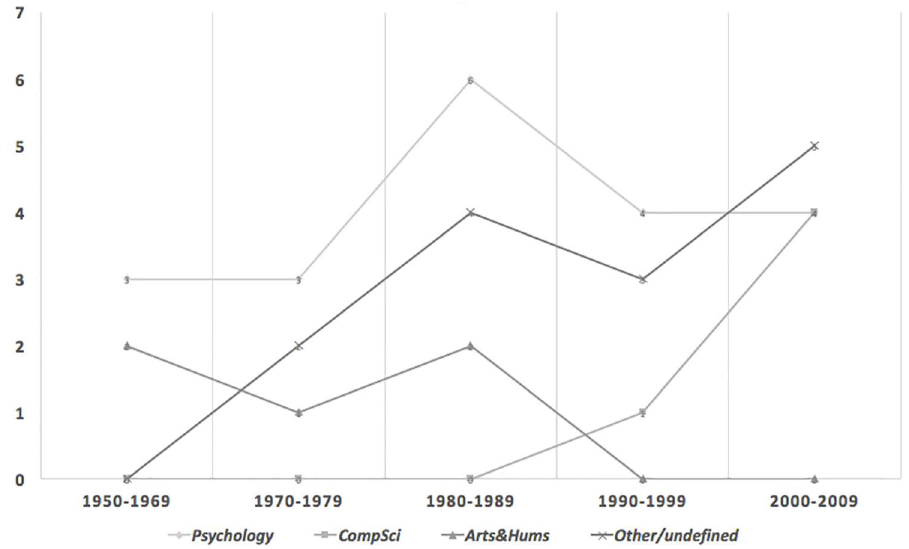
Fig 2. Representation of the disciplinary breakdown of the Creativity Corpus by time period. Disciplinesare as specified for the paper’sjournal, by the academicdatabase Scopus . Note that Scopus may classify a journal under more than one